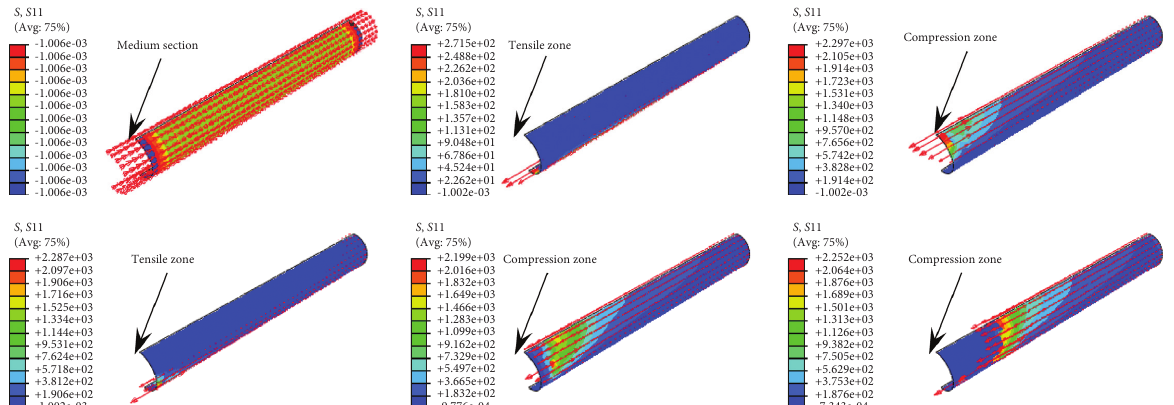
Figure 21: The CFRP’s longitudinal stress distribution in the specimens.